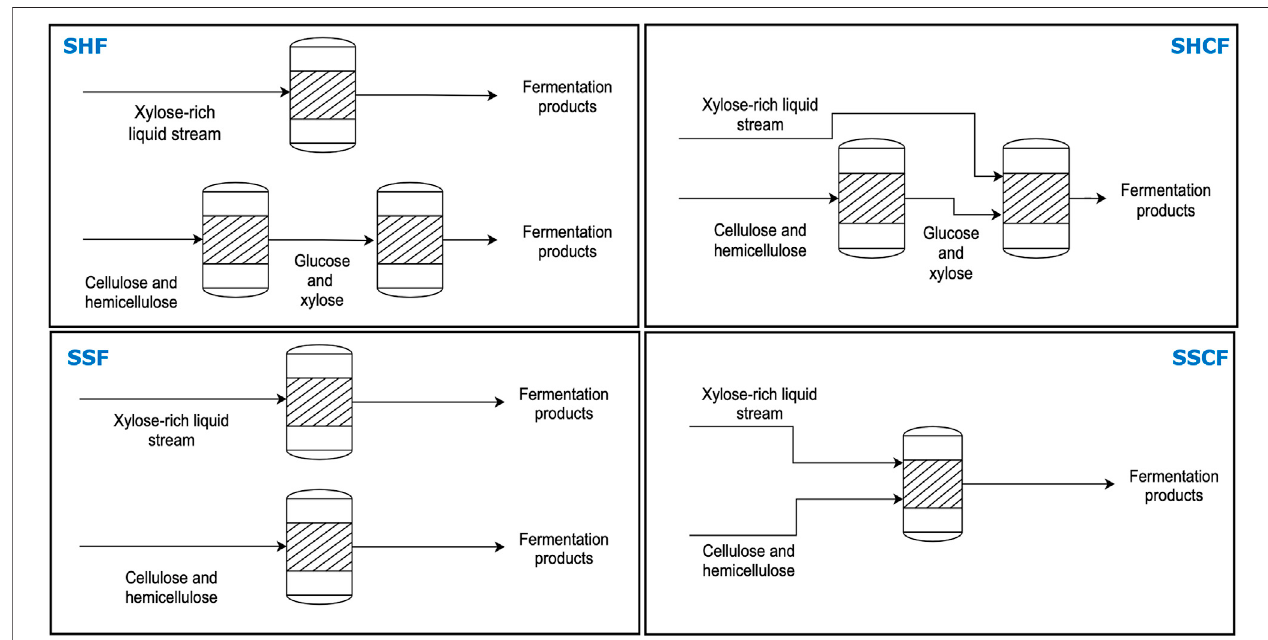
FIGURE 4 | Hydrolysis and fermentation con fi